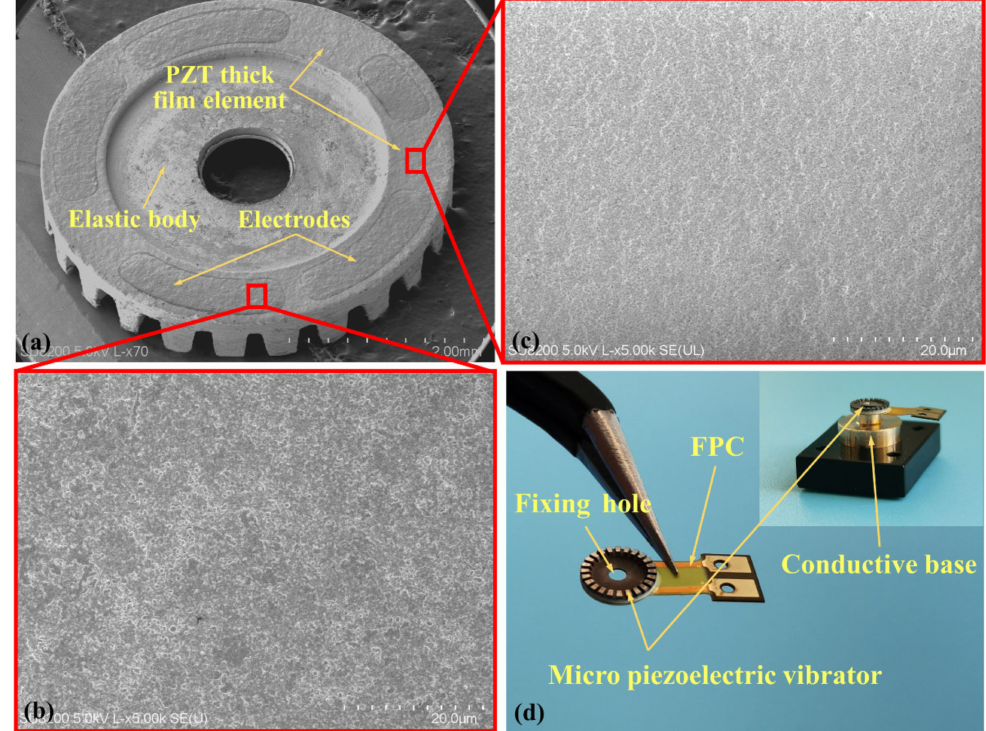
Figure 6. ( a ) PZT thick film micro vibrator, ( b ) micro morphology of printed thick films, ( c ) micro morphology of sputtered electrode, and ( d ) structure of assembled micro piezoelectric